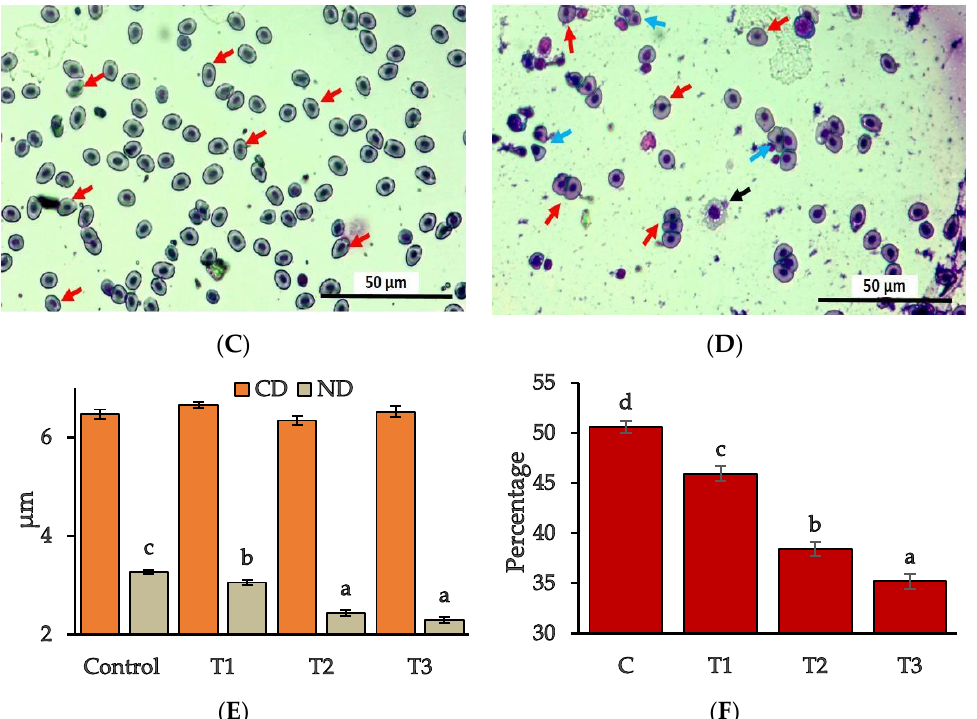
Figure 5. Microscopic view of erythrocytes in different treatment groups; ( A ) Control, ( B ) T 1 , ( C ) T 2 , ( D ) T 3 . (E — erythrocytes, EN — elliptical nuclei; red arrows — shrinking nuclei, black arrows — erythrocytes with rupturing cell membrane, blue arrows — shape deformities); ( E , F ) Quantitative analysis of erythrocytes in different treatment groups. Different superscripts indicate significant differences at p < 0.05 (CD — cell diameter, ND – nucleus diameter).